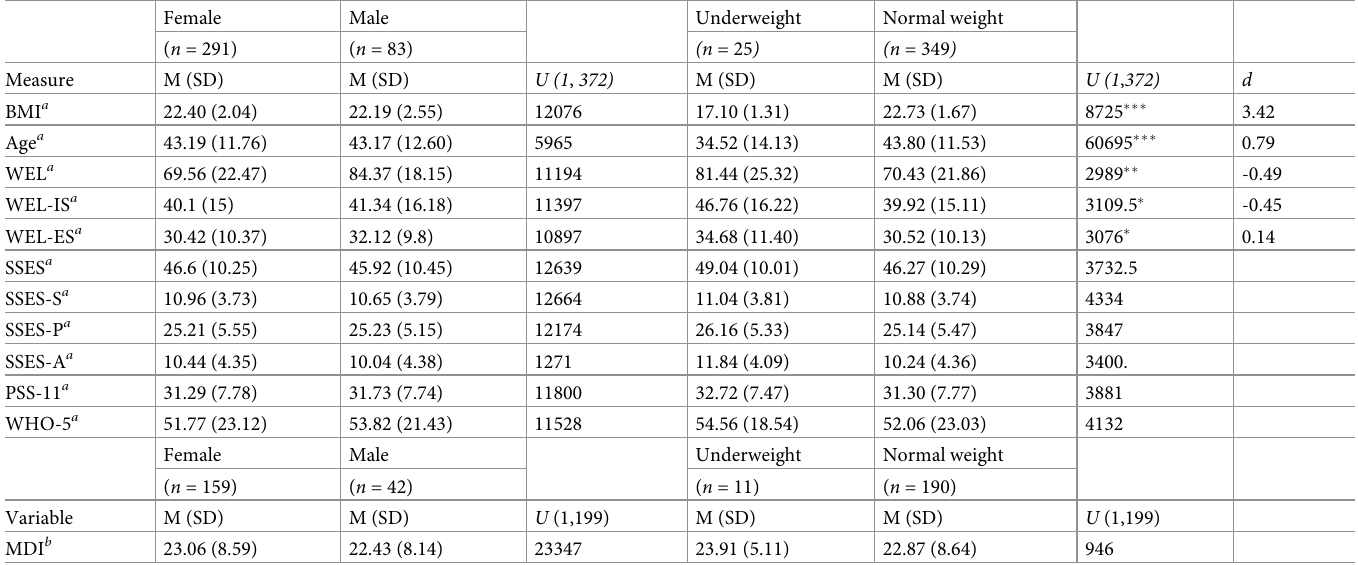
Table 5. Means, standard deviations and Wilcoxon–Mann–Whitney statistics for study 1